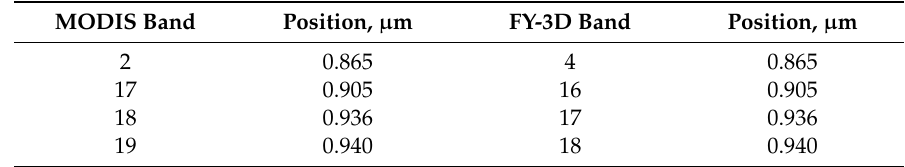
Figure 1. Comparison of spectral response functions of FY-3D MERSI-2 NIR bands against the MODIS near-infrared (NIR) bands. ( a ) FY-3D band 4 against MODIS band 2, ( b ) band 16 against band 17, ( c ) band 17 against band 18, and ( d ) band 18 against 19. Table 1. Comparison of FY-3D MERSI-2 bands with the corresponding ones of MODIS required for precipitable water vapor (PWV)